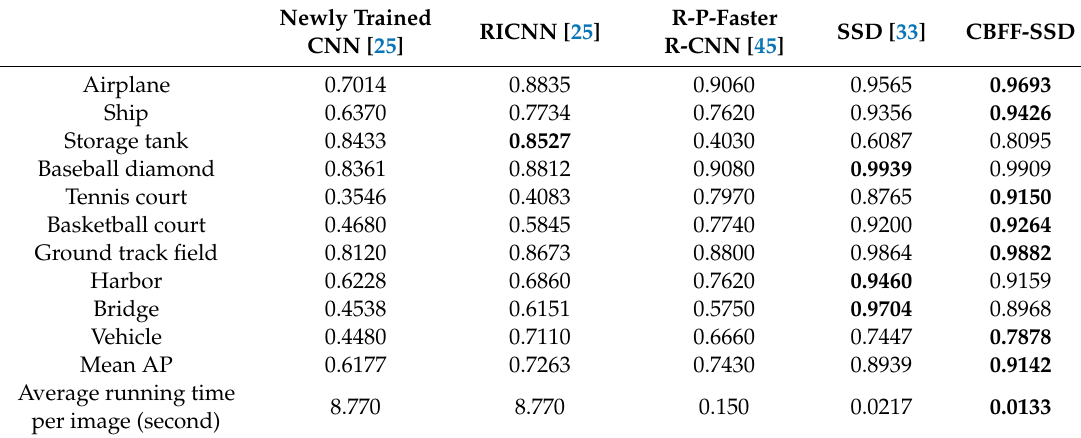
Table 3. Performance comparison of different algorithms.